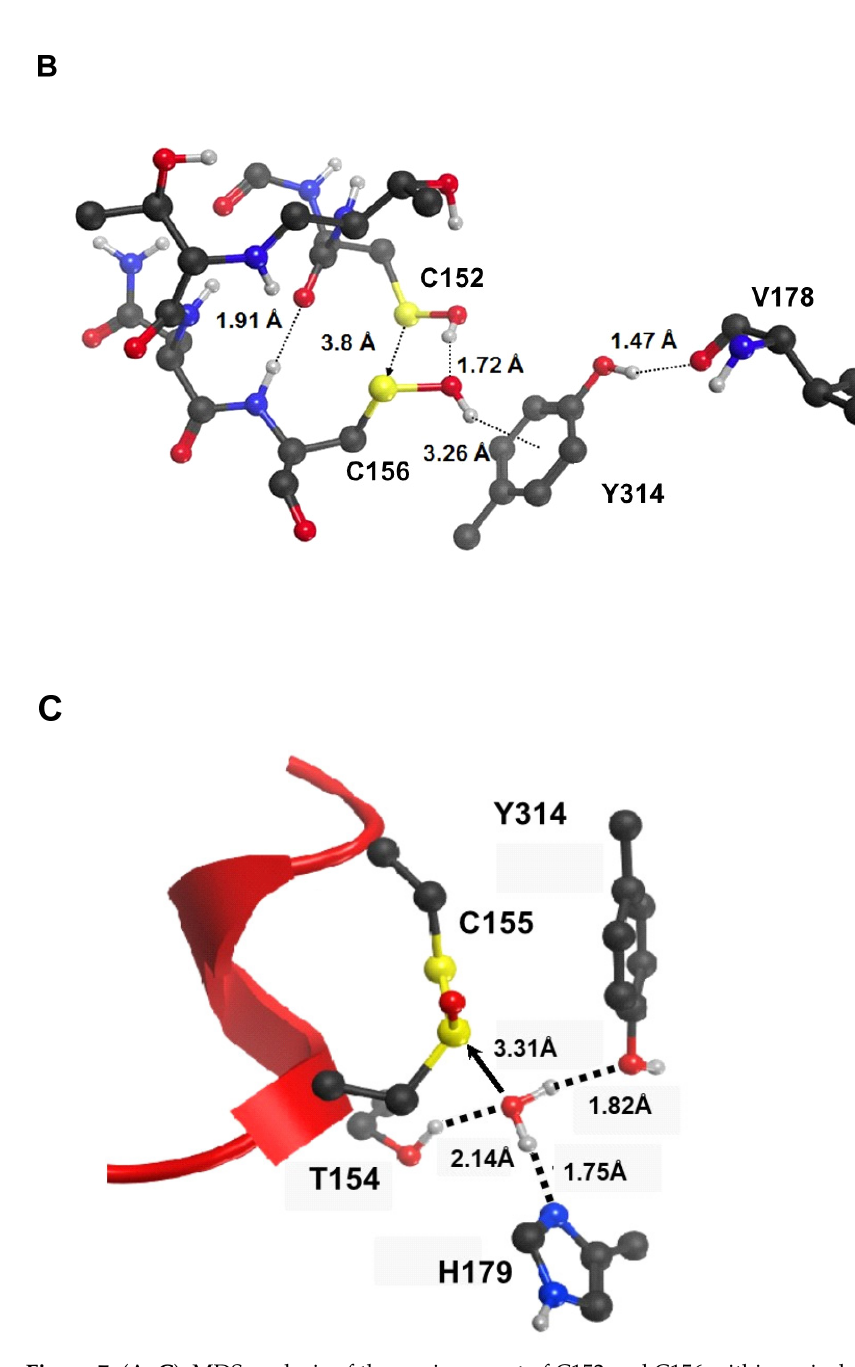
Figure 7. ( A – C ) . MDS analysis of the environment of C152 and C156 within an isolated h − GAPDH subunit to explore the mechanistic interpretation of the biochemical data. ( A ) The catalytic region of h − GAPDH (PDB1u8f) within the crystal structure of an isolated subunit shows the placement of an H 2 O 2 juxtaposed to C156 (C v (SH). After MDS, the H 2 O 2 molecule docks forming strong bifurcated hydrogen bond donors (T153, H179) and strong hydrogen bond acceptors (C152 sulfenic acid and Y314) which polarize and activate the H 2 O 2 molecule for nucleophilic attack by C156. The acidic protons contributed by H179 and C152 sulfenic acid provide a rational basis for the observed decline in H 2 O 2 oxidation of C156 with rising pH ( B ). Following Steered Molecular Dynamics (SMD), the two sulfur centers are within the van der Waals contact distance for covalent bond formation. Formation of strong H − bonds between the C156 sulfinic acid acidic proton and C152 sulfinate oxygen, as well as the C152 sulfinic acid proton and delocalized Y314 π − orbitals promote nucleophilic attack of its sulfur atom on C156 sulfenic acid sulfur atom as water is an excellent leaving group. The model provides a rational basis for the experimental data proving directional nucleophilic attack resulting in a thiosulfinic acid with the sulfinyl center at C152 and the sulfenyl center at C156. ( C ). A plausible